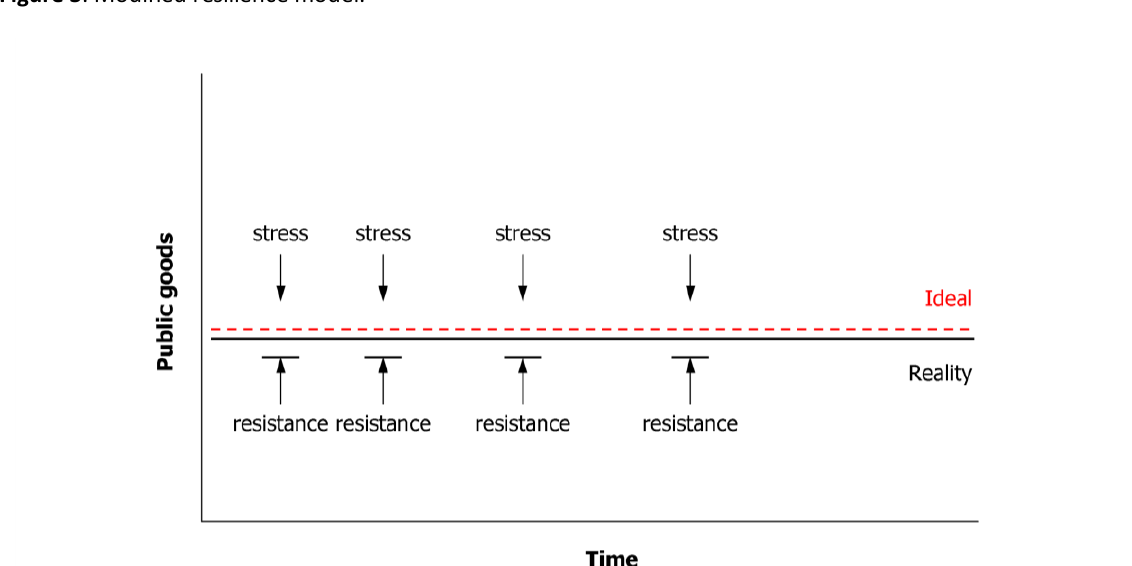
Figure 3 . Modified resilience model.